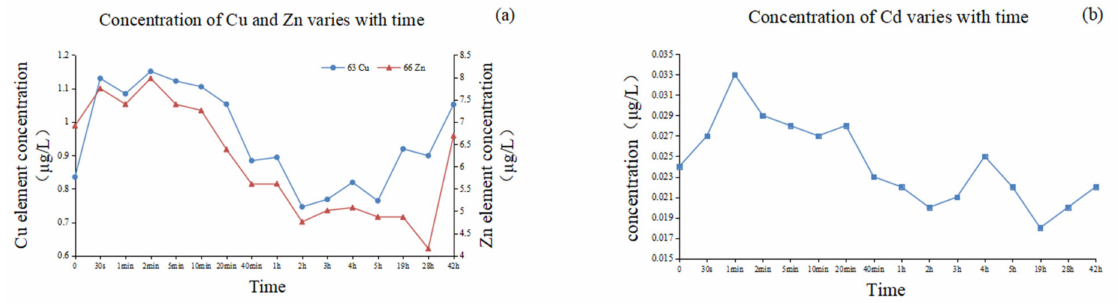
Figure 13. In conventional treatment water the effects of suspended particulate matter at different time adsorption and release of Cu and Zn ( a ); Cd ( b ).